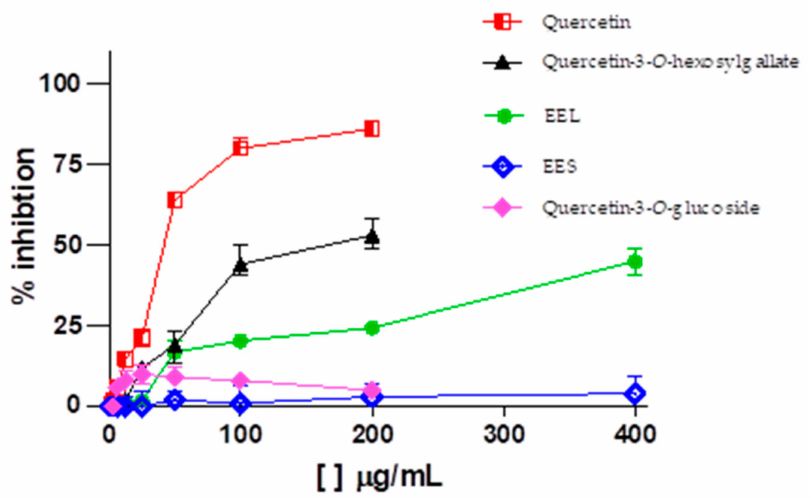
Figure 3. Dose–response curves for anti-Zika activity of ethanolic extracts and constituents from Curatella americana (EEL—ethanol extract of leaves, EES—ethanol extract of